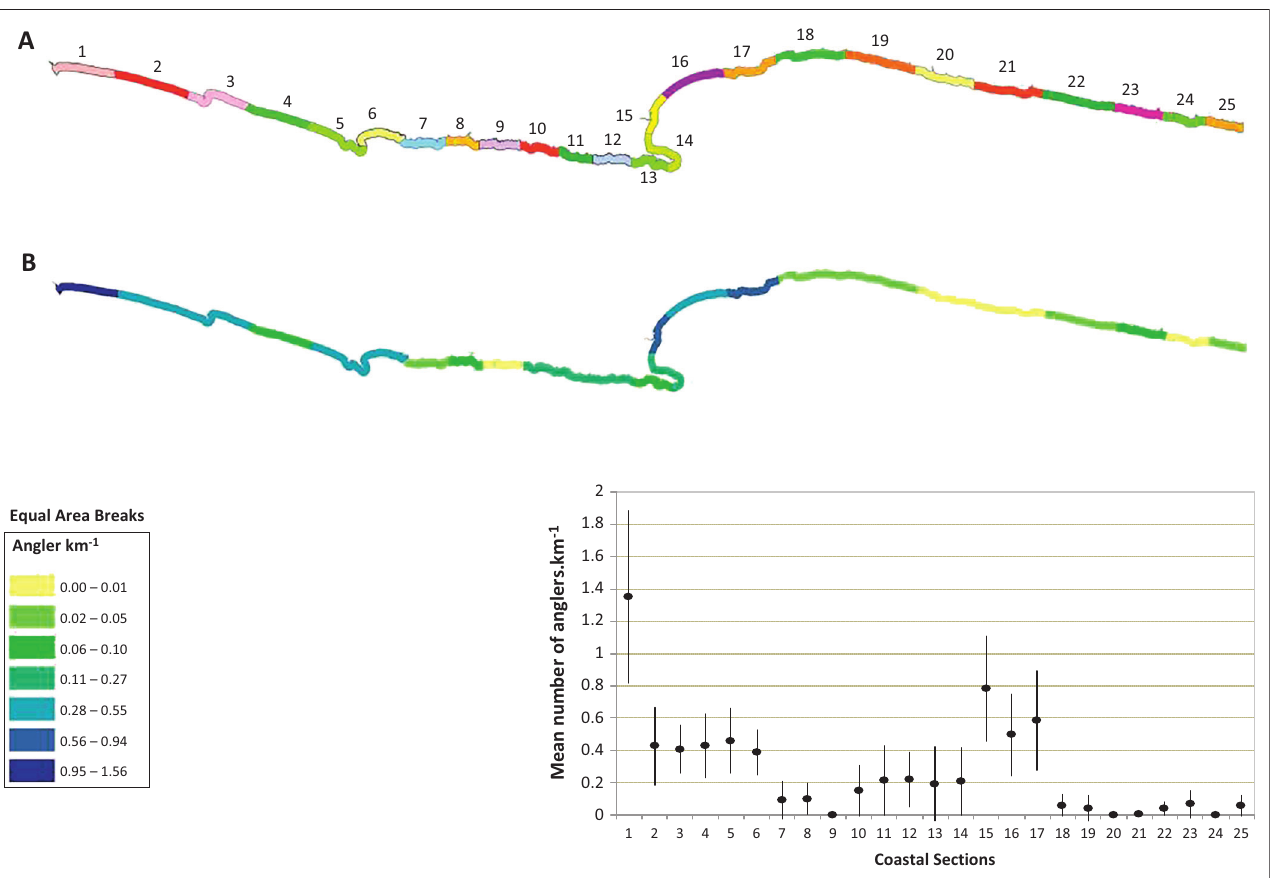
FIGURE 2: The South African Garden Route coastal section broken into equal areas (A) and the spatial distribution of total angling effort (anglers.km -1 ) between Kaaimans River in the west and the eastern border of the Tsitsikamma Marine Protected Area at the Groot River (B). Up–down bars indicate the 95 % confidence